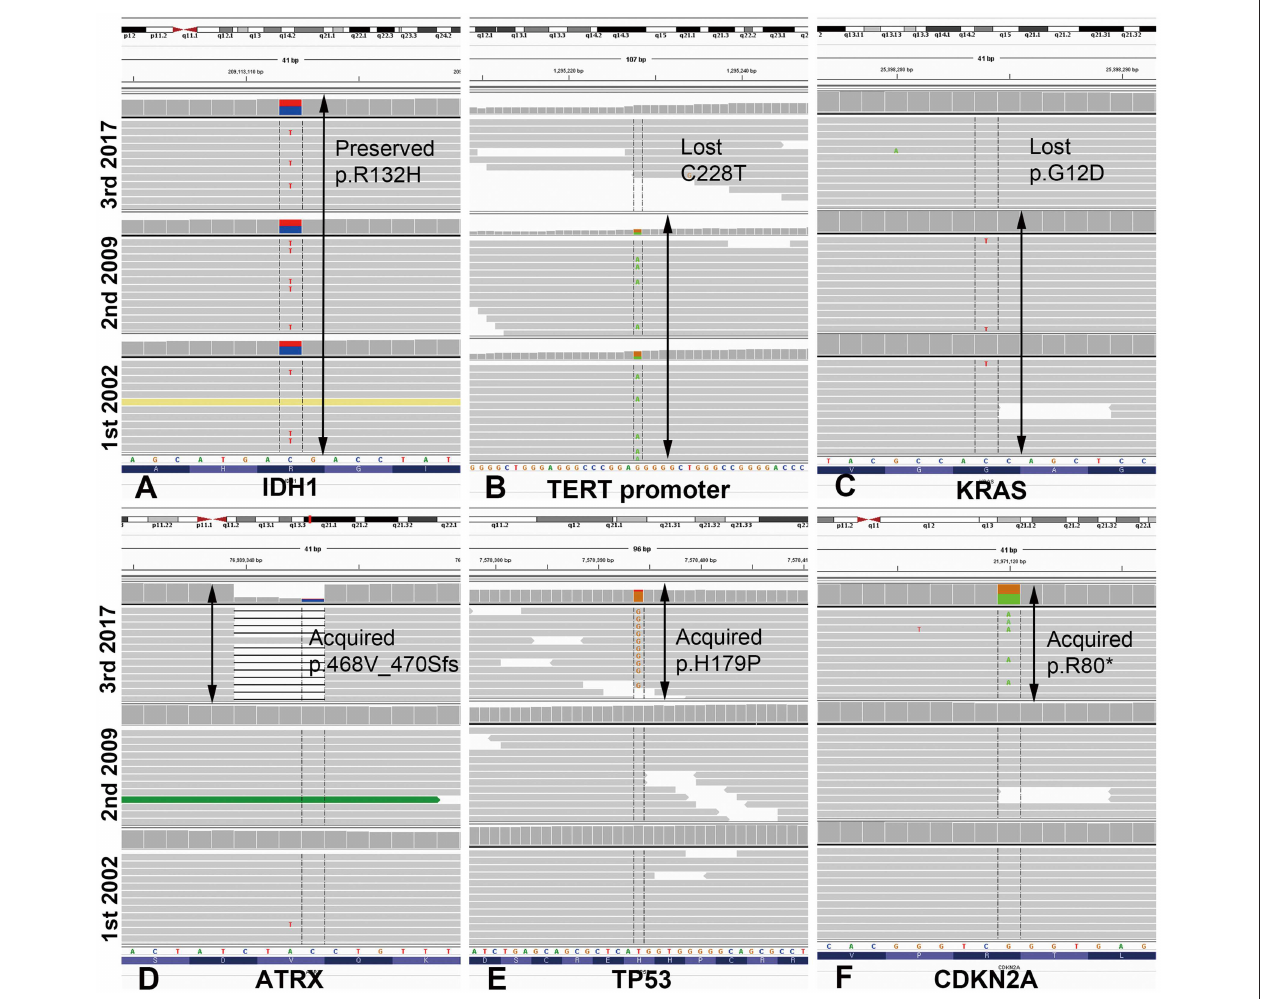
FIGURE 2 | Illustration of mutations detected by next-generation sequencing analysis in case 1, visualized in Integrative Genome Viewer. IDH1 mutation R132H was preserved at the same loci as that of the original tumor in the most recent recurrence (A) . TERT promoter mutation C228T and KRAS mutation G12D were maintained from the original to the recurrent anaplastic oligodendroglioma, but were lost in the recurrent astrocytoma (B,C) . By contrast, mutations of ATRX, TP53, and CDKN2A were newly acquired at the most recent astrocytoma recurrence. Arrows indicate the retention of the same mutations at each recurrence (D–F) . *ATRX, alpha-thalassemia/mental retardation X-linked; IDH, isocitrate